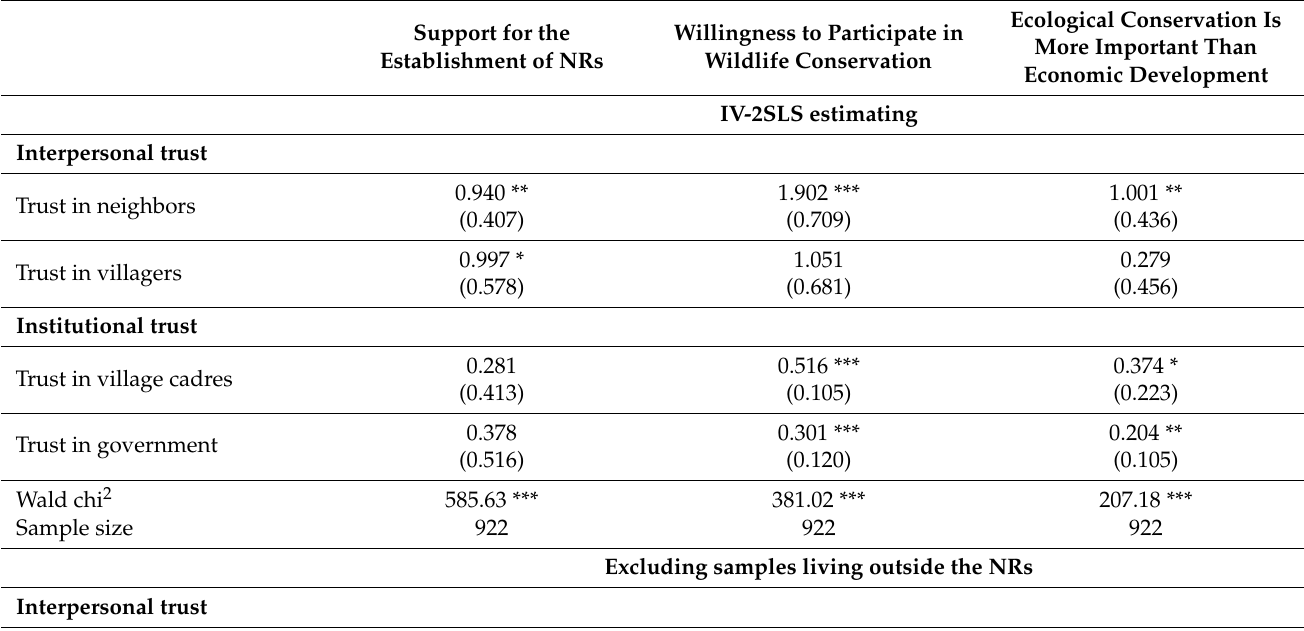
Table 3. Robustness test